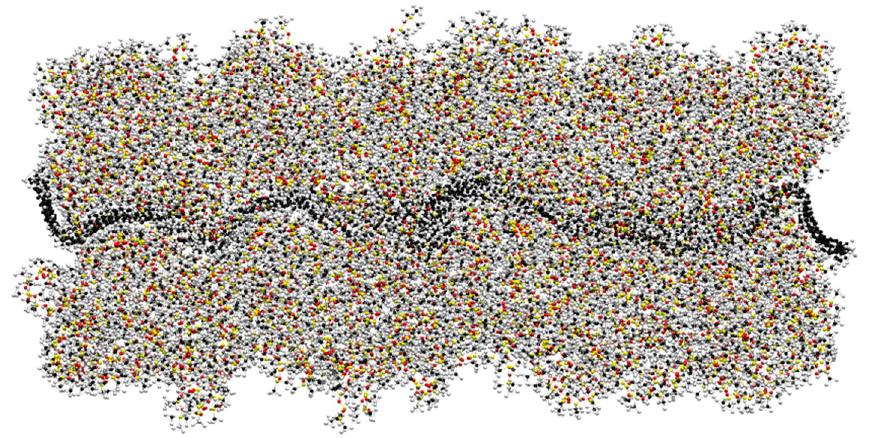
Figure 4. PDMS polymer surrounding graphene flakes jointed by three C5OP linkers hindered by the polymer). Color codes: carbon atoms in black, oxygen in red, hydrogen in light gray and silicon in yellow.